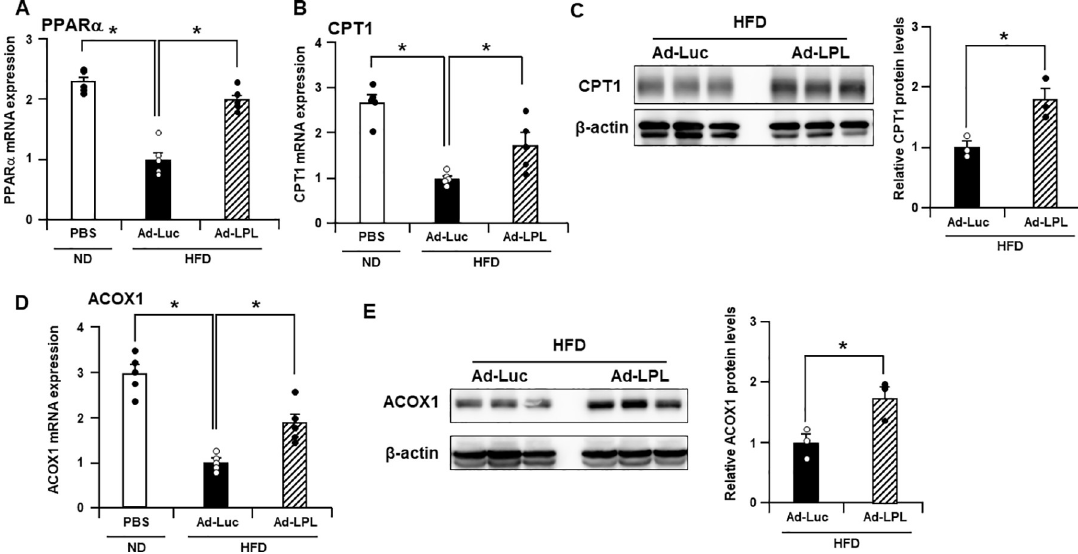
Fig 3. Hepatic LPL overexpression upregulates fatty acid oxidation-related genes and protein in HFD-fed mice. Male C57BL/6 mice were intravenously treated with Ad vectors via the tail vein and were simultaneously fed HFD. PBS-treated mice were fed ND throughout the experimental period. Hepatic (A) PPAR α , (B) CPT1, and (D) ACOX1 mRNA levels in male C57BL/6 mice 2 weeks after administration of Ad-LPL, Ad-Luc, or PBS determined using quantitative RT-PCR. The data were normalized to the corresponding value in the Ad-Luc-treated group. One-way ANOVA with Dunnett’s post hoc tests was used for multiple comparisons. The data are expressed as the mean ± standard error (n = 5). Hepatic (C) CPT1 and (E) ACOX1 protein levels in male C57BL/6 mice 2 weeks after administration of Ad-LPL or Ad-Luc determined using western blot analysis. The quantification data were normalized to the corresponding value in the Ad-Luc-treated group. The Mann–Whitney U test was used to compare the differences between two independent groups. The data are expressed as the mean ± standard error (n = 3). � , P < 0.05 vs. Ad-Luc.